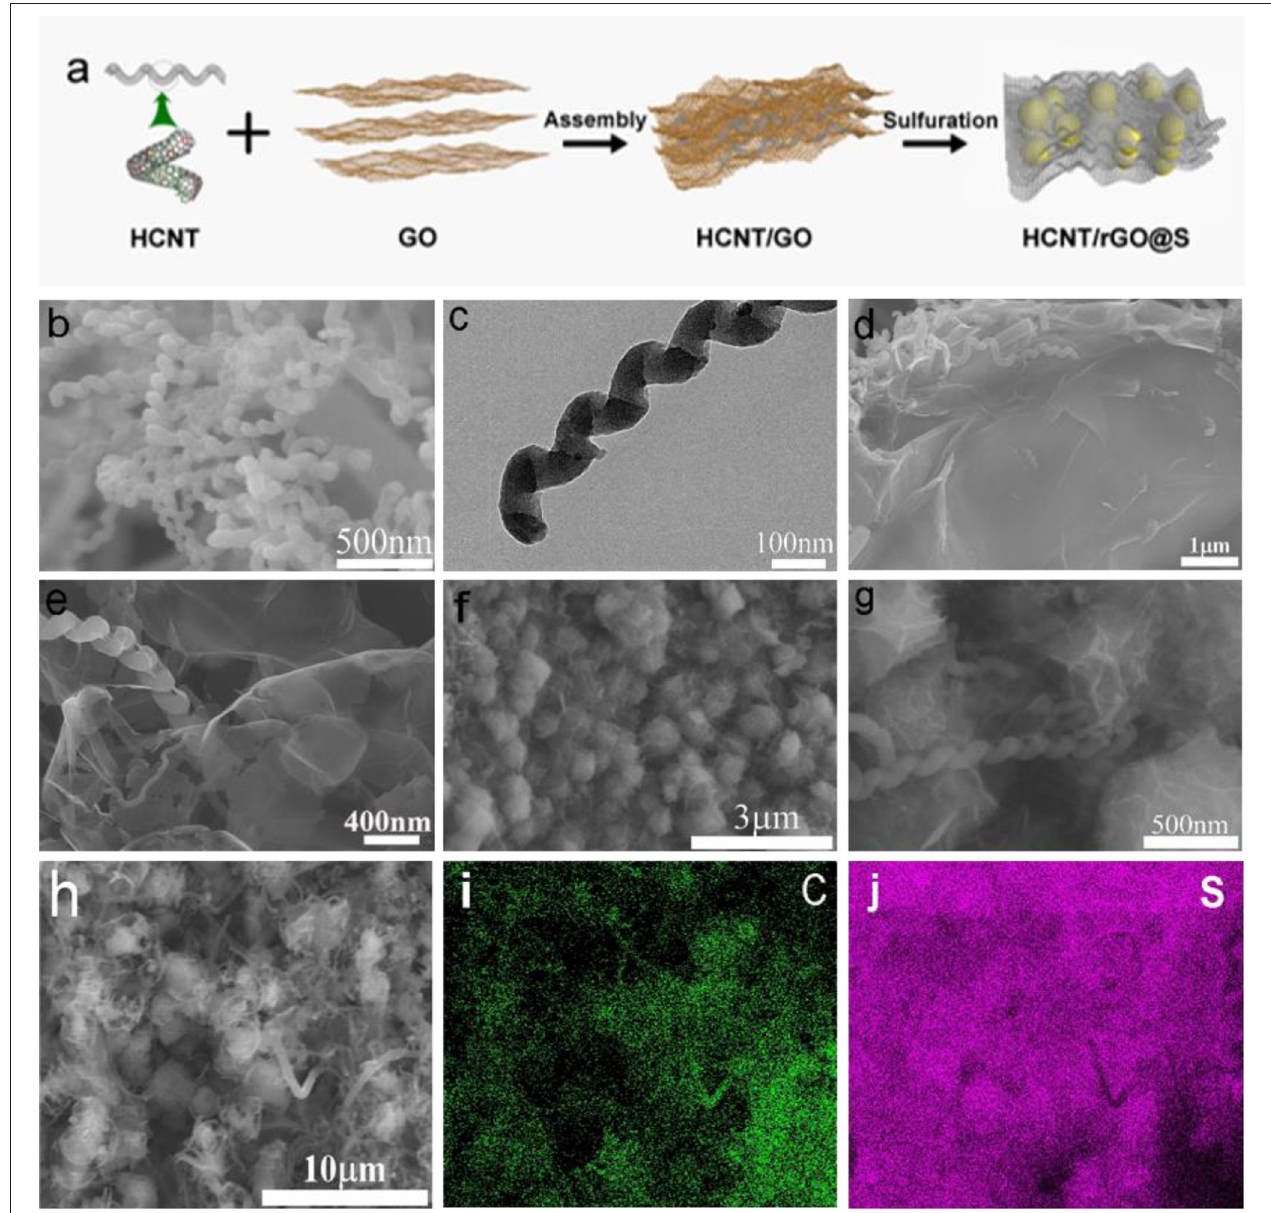
FIGURE 1 | (a) Schematic of the synthetic process of the helical carbon nanotubes (HCNT)/reduced graphene oxide (rGO)/sulfur (S) electrode. The SEM (b) and Transmission electron microscope (TEM) (c) image of HCNTs. The SEM (d,e) of HCNT/GO. The SEM (f,g) of HCNT/rGO/S. (h) SEM images and (i,j) elemental mapping of the HCNT/rGO/S